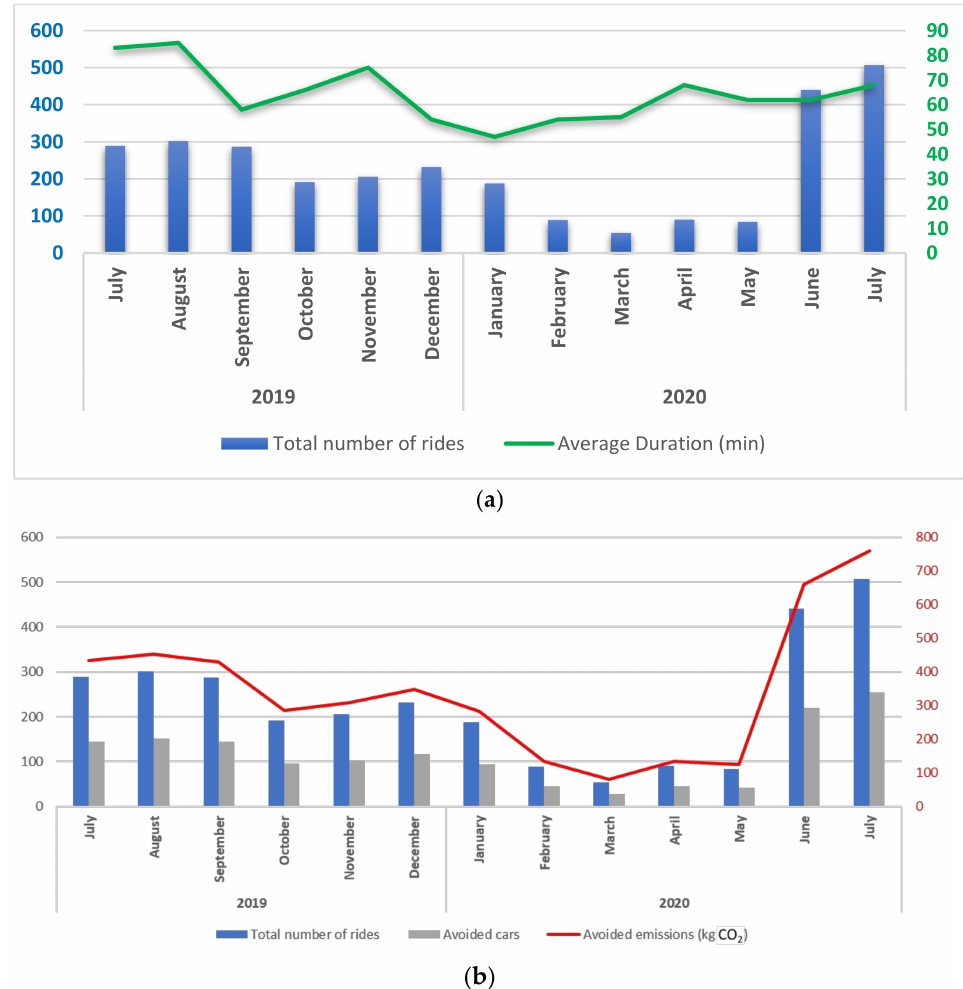
Figure 8. ( a ) Combo chart for Chania’s BS system relating number of rides per month and avoided cars to number of avoided km. ( b ) Combo chart for Chania’s BS system relating number of rides per month and avoided cars to number of avoided emissions (kg of CO 2